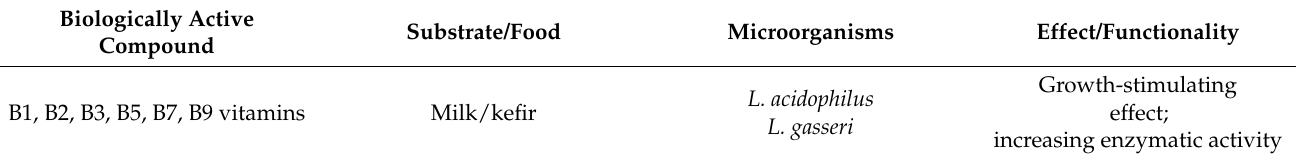
Table 3. The most notable other bioactive